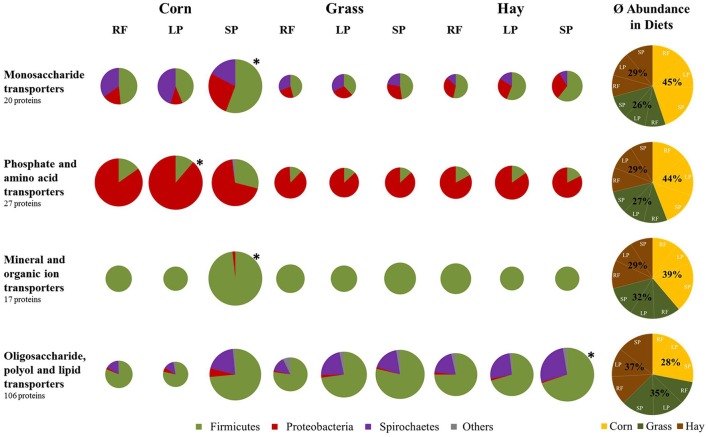
Varying abundance of bacterial ABC transporters in diets and sample fractions (n = 3). Pie sizes indicate the abundance in relation to the sample with the maximum LFQ-values (*) in each group. Phylogenetic origin of proteins in the respective samples is shown at phyla level. RF, rumen fluid; LP, liquid phase; SP, solid phase.